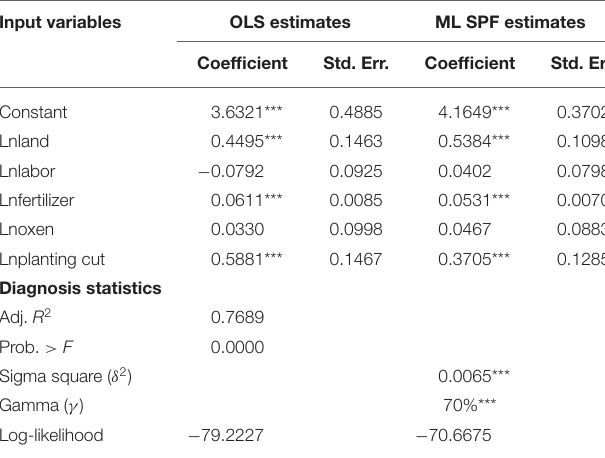
TABLE 5 | Estimates of the OLS and SPF CD production function. TABLE 6 | Maximum likelihood estimates of the parameters of the CD SPF.